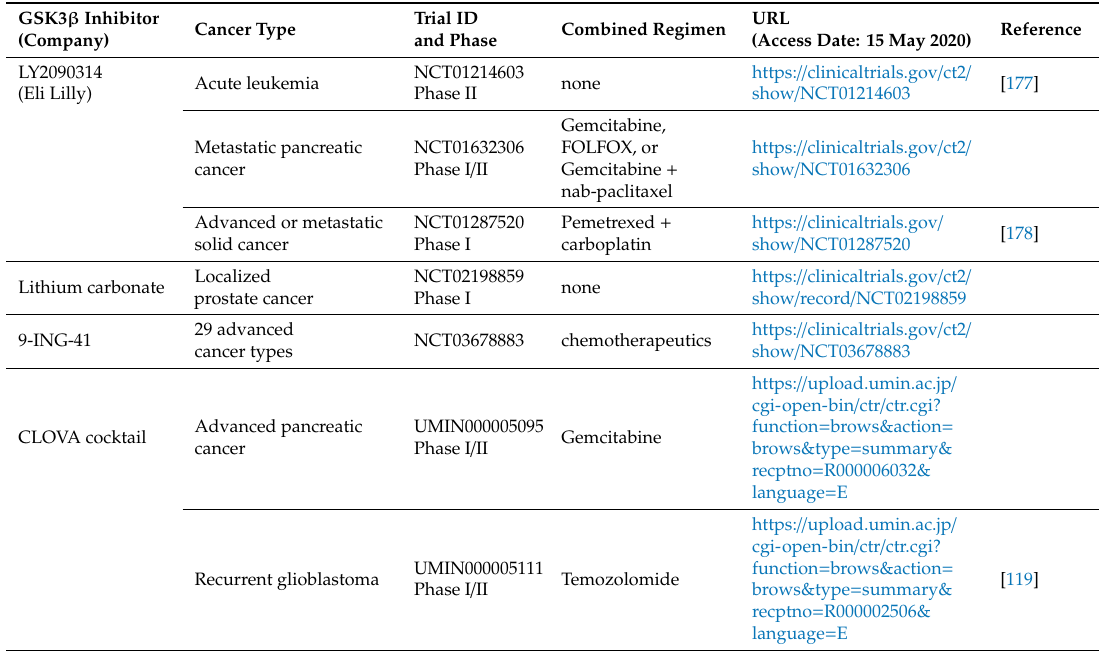
Table 2. Clinical trials of GSK3 β inhibitors for treatment of cancer